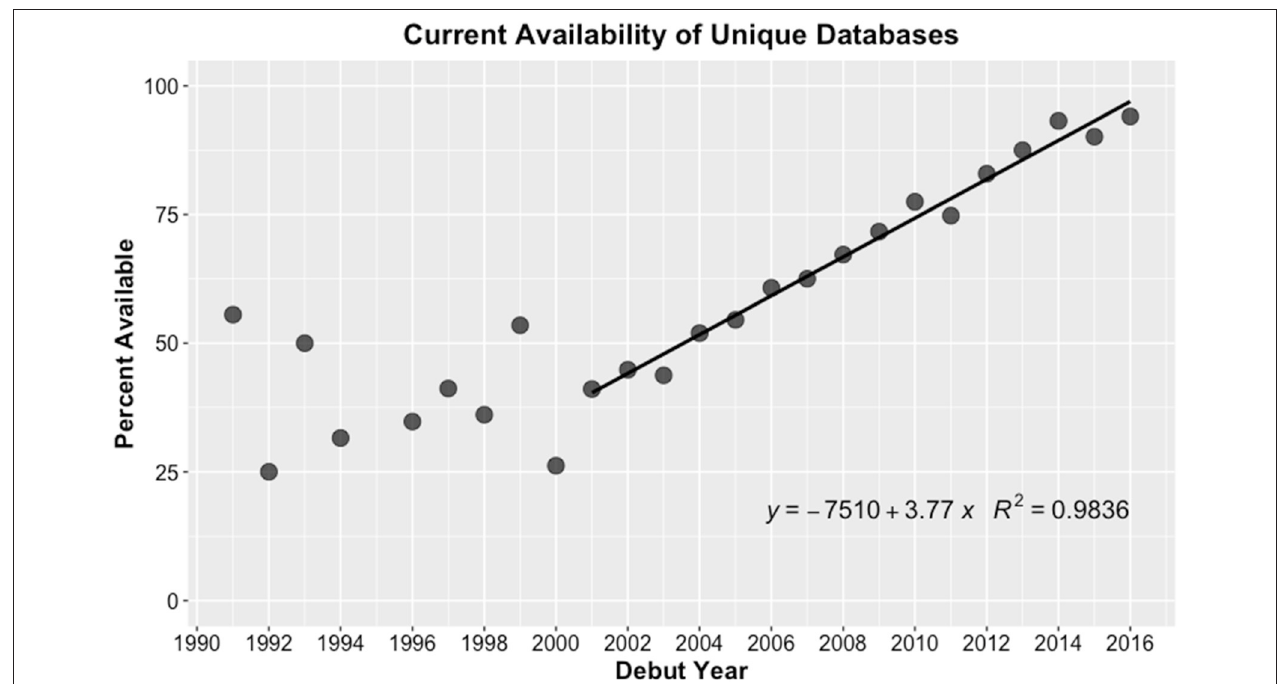
FIGURE 4 | In this study, URLs for each unique database were tested to determine the rate of database attrition. Databases show linear attrition for those debuted between 2001 and 2016, with maximum curvature in 2001. For earlier years, although the data here indicate retention is highly variable, database availability ceases to decline steadily.